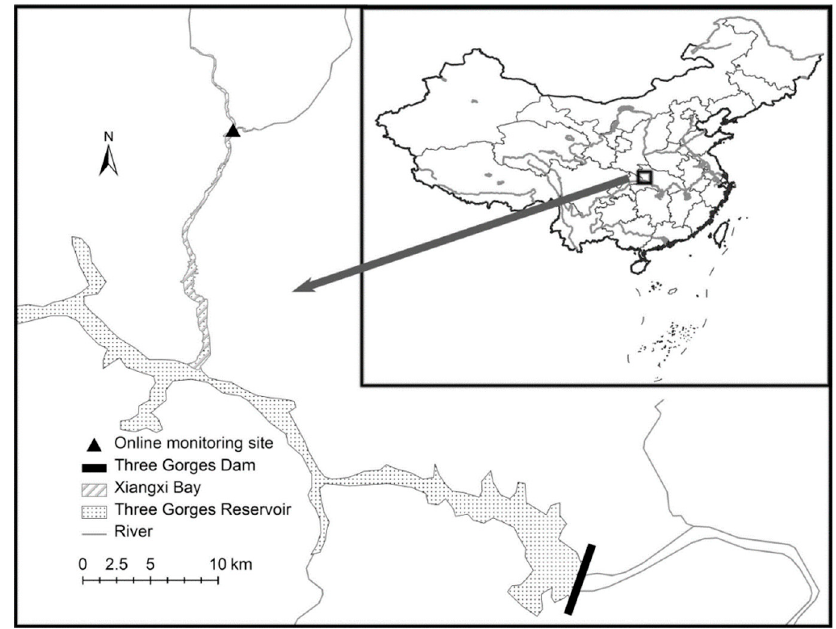
Figure 1. Location of the study site.